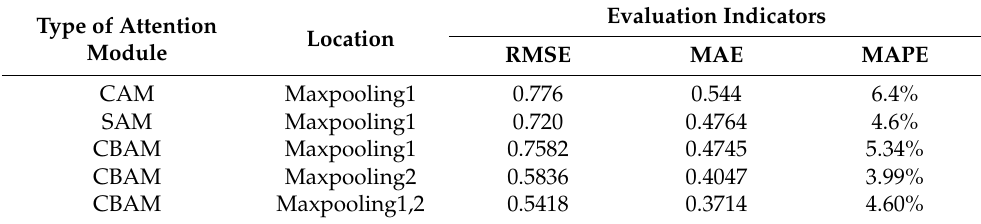
Table A1. Performance of the model with different positions of the attention module.